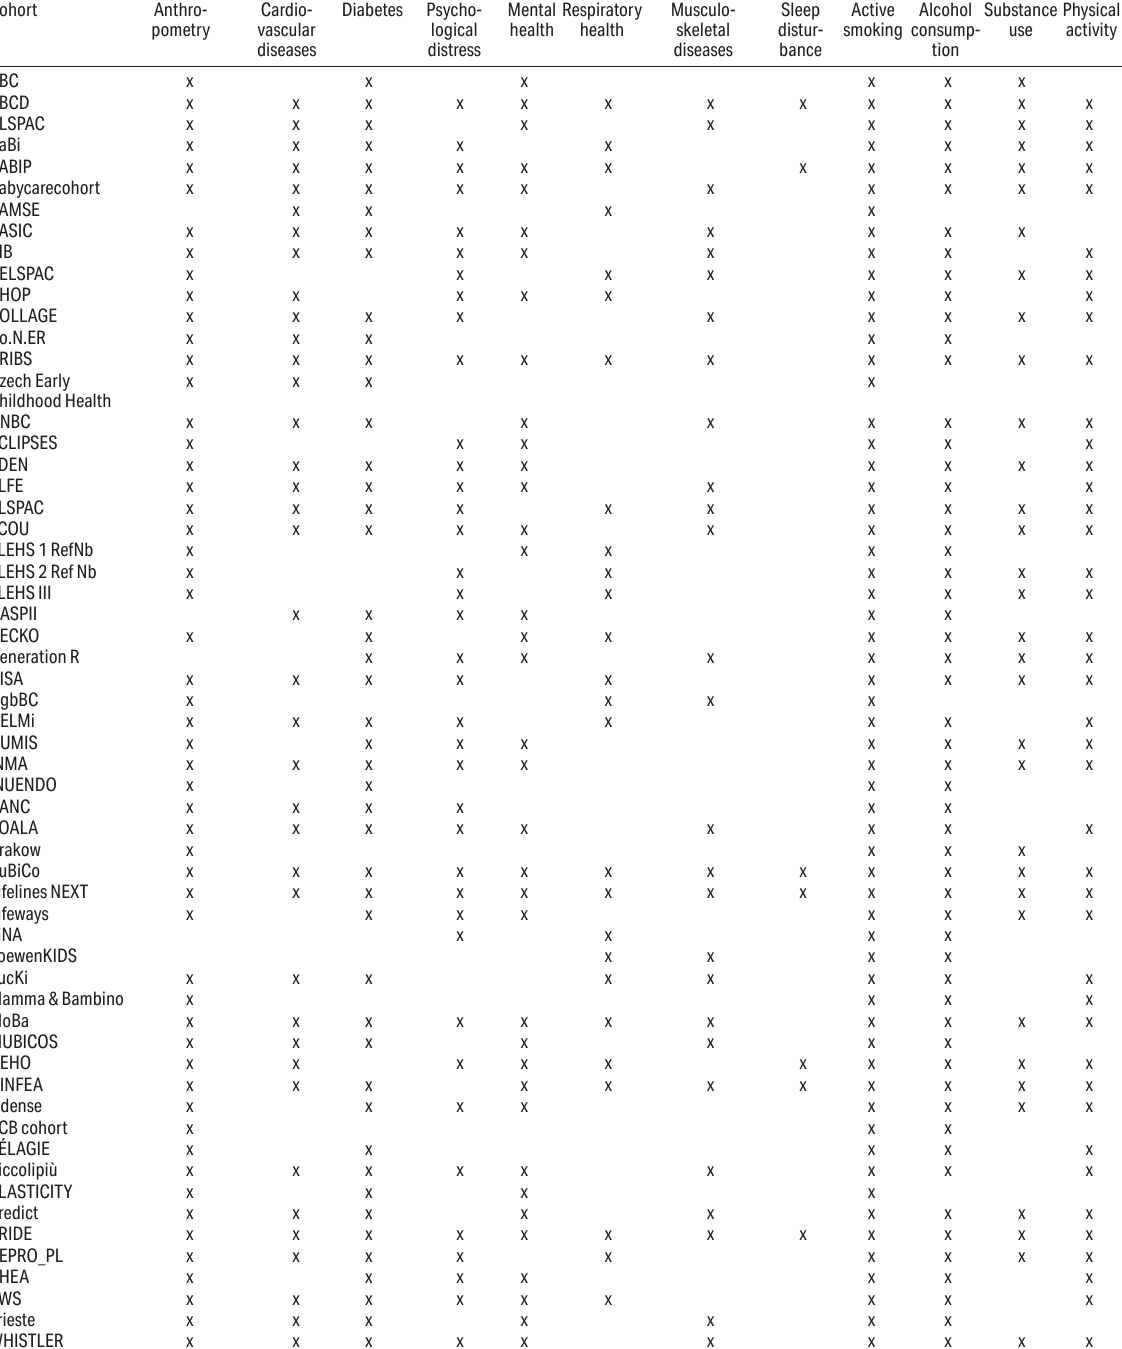
Table 2. Selected mothers’ health conditions and determinants collected in 59 European birth cohorts (as reported in www.birthcohorts.net cata - logue, accessed on 5 Feb